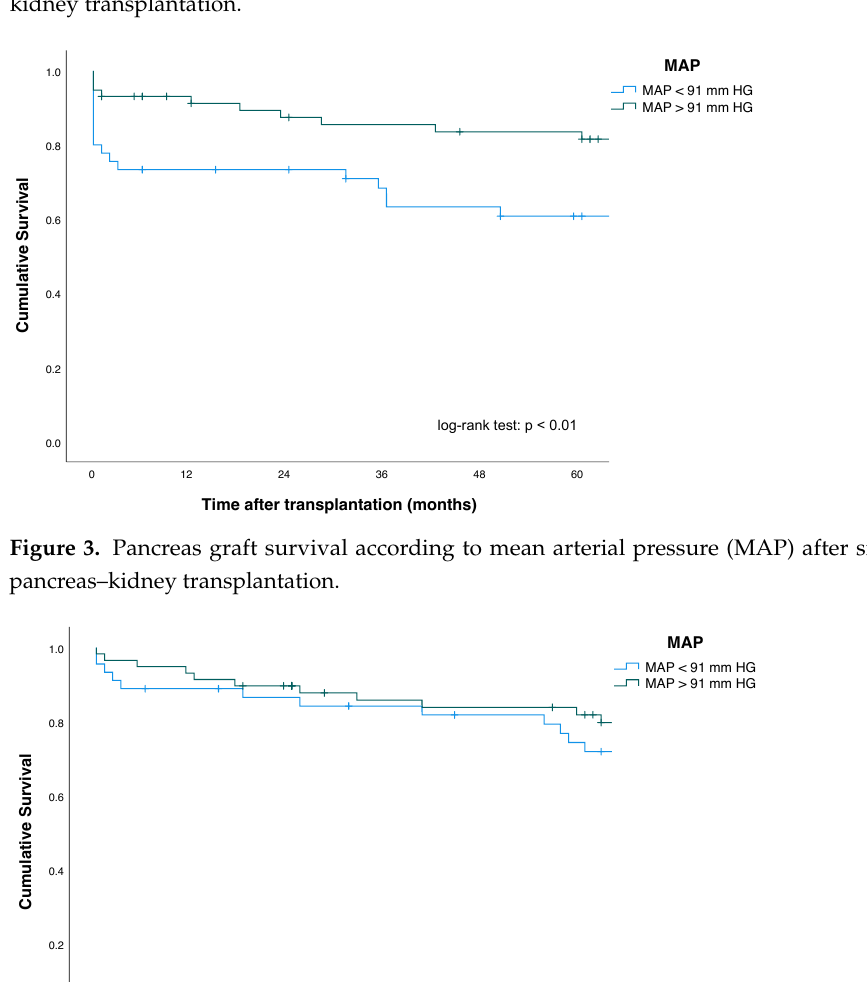
Figure 2. Patient survival according to mean arterial pressure (MAP) after simultaneous pancreas- kidney transplantation.